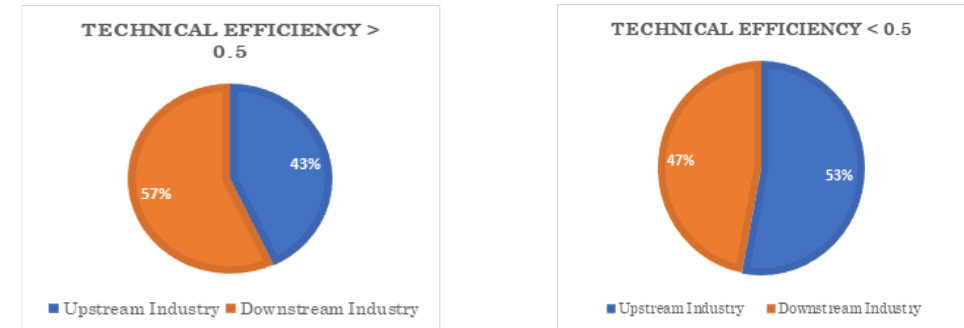
Figure 3: The proportion of Upstream and Downstream Textile and Textile Products Indus - tries Based on the TE classification> 0.5 and TE <0.5